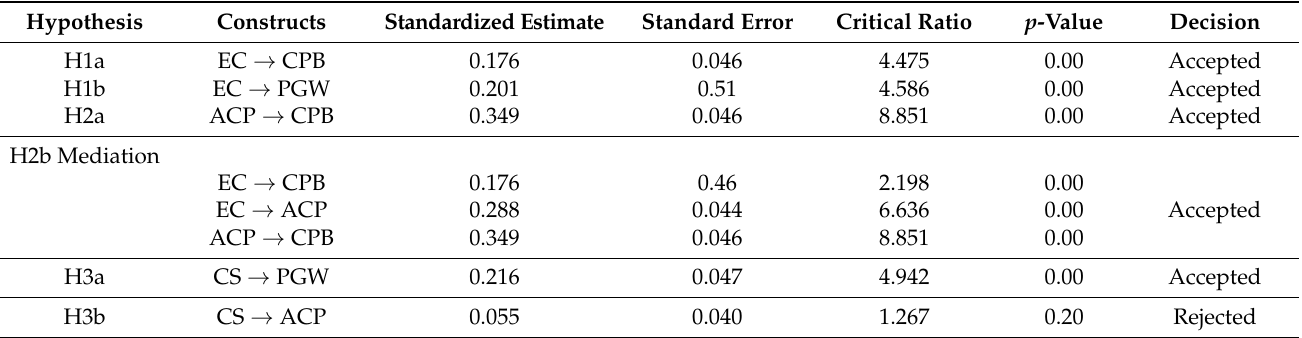
Table 6. Results of hypothesis